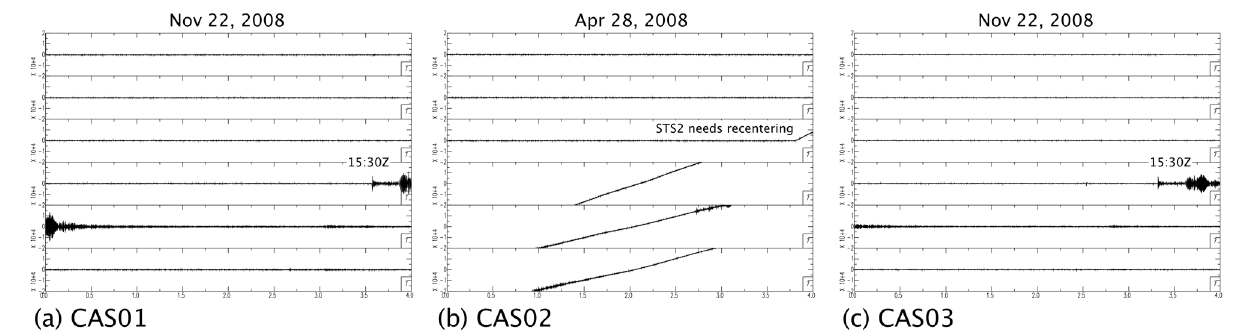
Figure 5. Examples of 2008 data from the prototype stations. Each panel shows one day of data, split into six 4-hour segments. At CAS02 (b), the STS-2 seismometer has drifted too far of center, causing the trend in the data (the mean of each segment is removed from the data before plotting). Panels (a) and (c) show the same event, but given the failure of the GPS units during the first winter (see text) the apparent timing is significantly different between the